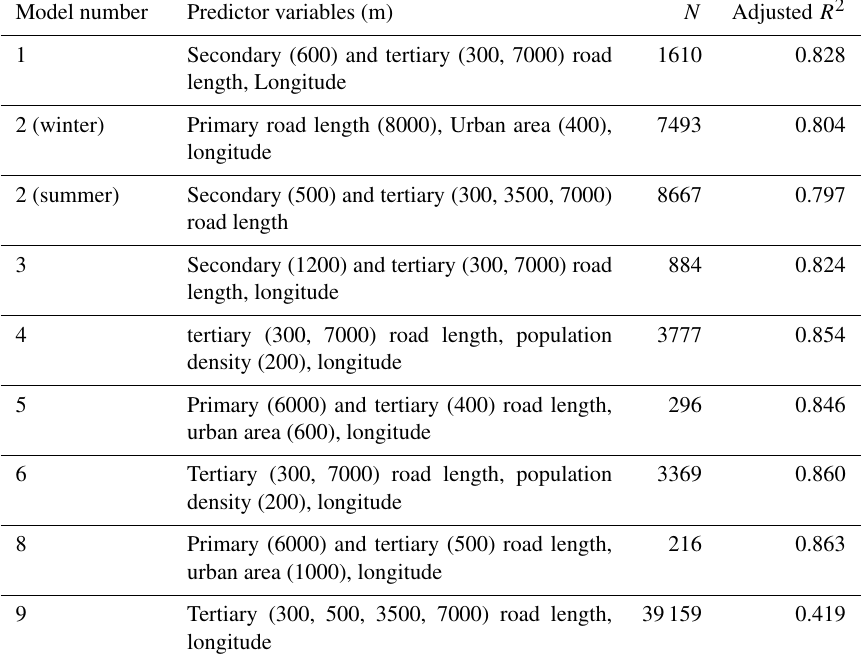
Table 3. Description of the LUR models shown in Table 2, showing the predictor variables (including buffer radii where applicable) and adjusted R 2 . Models combining OMI and SCIAMACHY data failed to converge regardless of predictor variable, so no viable dataset was produced for Model